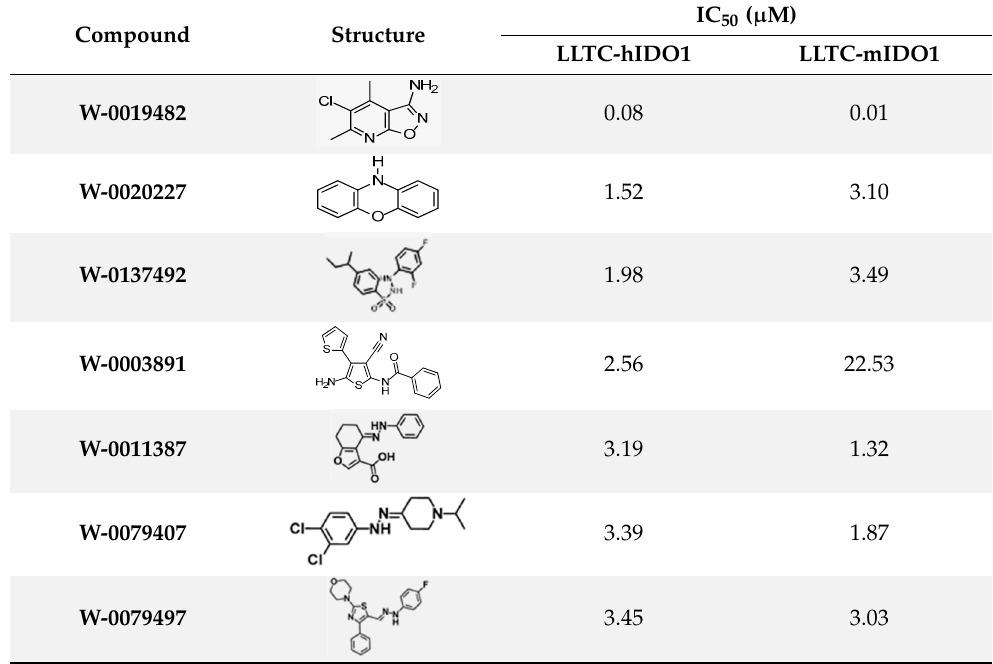
Table 1 . IC 50 values for individual WEHI “hits” against LLTC-hIDO1 or LLTC-mIDO1 . Compound Structure